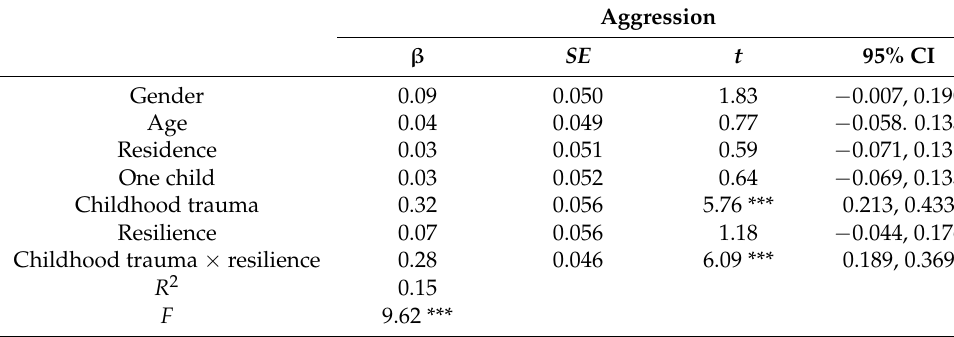
Table 3. Testing the moderation effect of resilience.